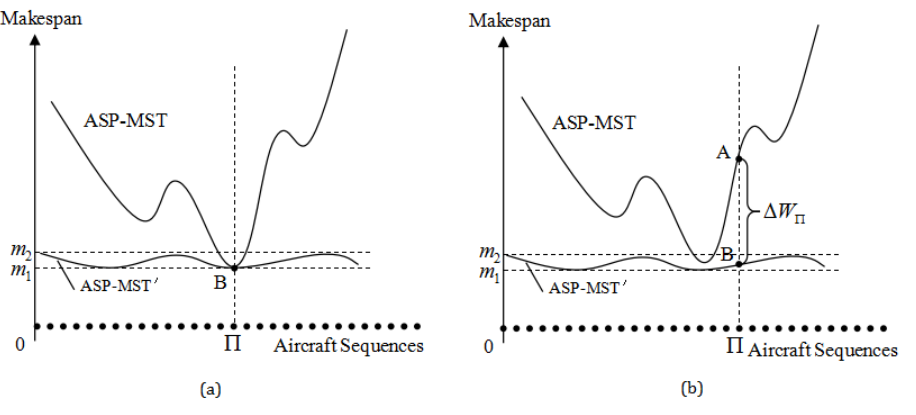
Figure 3. Makespan of sequences in ASP-MST and ASP-MST (cid:48) . ( a ) the optimal solution appear in point B ; ( b ) the optimization process is to minimize ∆ W Π